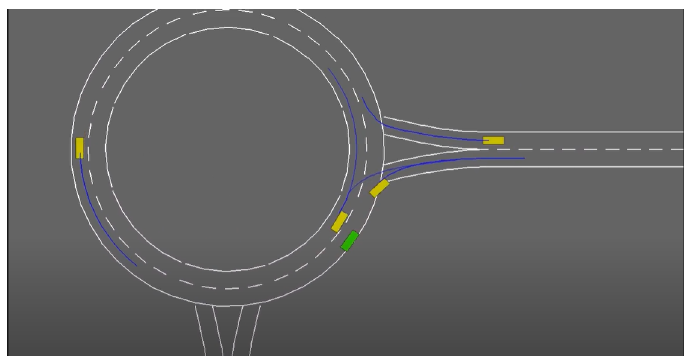
Figure 12. Model with robust control framework implemented.